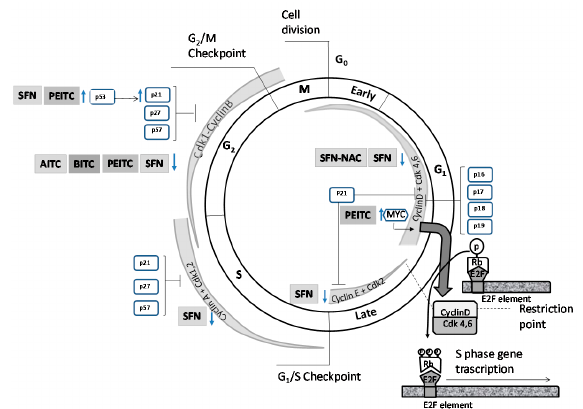
Figure 2. Effects of ITCs in vitro on cell cycle regulation by Cdk/cyclin holoenzymes and CKIs. Abbreviations: ↑ , enhanced expression or protein levels; ↓ , reduced expression or protein levels; AITC, allyl isothiocyanate; BITC, benzyl isothiocyanate; PEITC, phenethyl isothiocyanate; SFN, sulforaphane; SFN-NAC, N -acetylcysteine conjugate of sulforaphane.